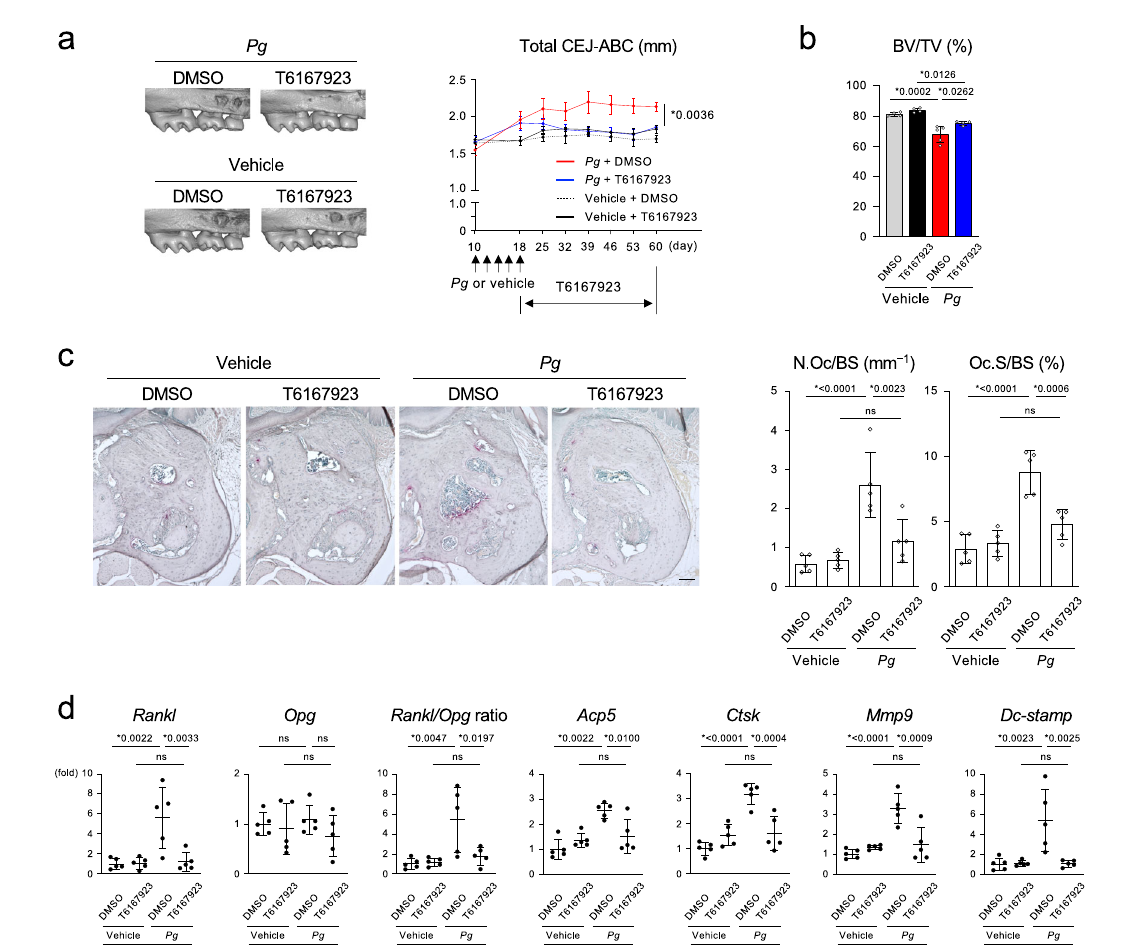
Fig. 8 | Administration of an MYD88 inhibitor protects against alveolar bone loss in periodontitis induced by Porphyromonas gingivalis infection. a Left: MicroCTimagesoftherightmaxillafrom Porphyromonasgingivalis ( Pg )-orvehicle- inoculated wild-type C57BL/6J male mice administered with T6167923 or DMSO. Buccal side view. Representative images from eachgroup of male mice. Right: The total CEJ-ABC distance at the right maxillary molars. b Alveolar BV/TV underneath the right maxillary second molar. a , b Pg +DMSO ( n =5), Pg +T6167923 ( n =4), Vehicle+DMSO ( n =4), Vehicle+T6167923 ( n =4). c Left: TRAP staining of the